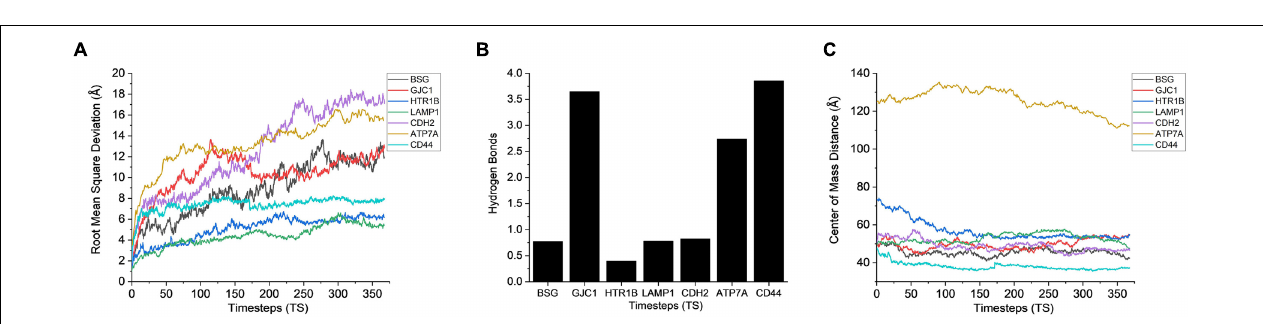
FIGURE 6 | Interaction energy analysis for CHO (A) extracellular proteins (1 TS = 105 ps) and (B) plasma membrane proteins with AMB-1 bacteria (1 TS = 136 ps).